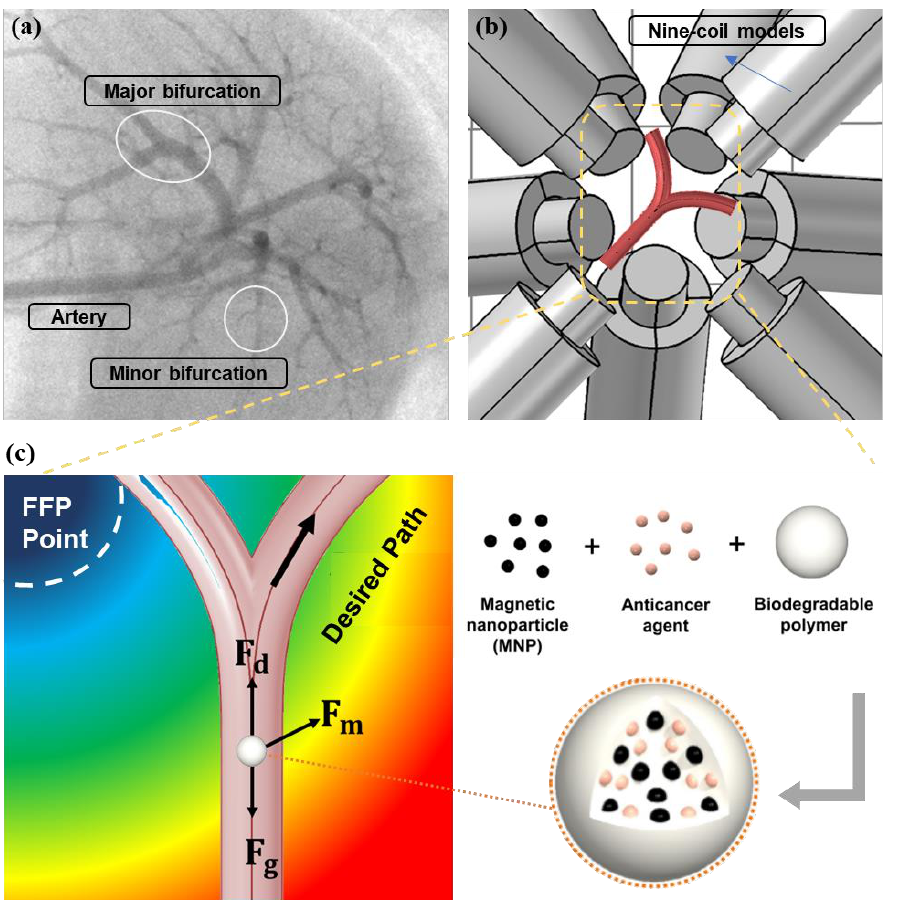
Figure 1. ( a ) Complexity of endovascular navigation in the portal vein of the rat. ( b ) Animated description of Y-shaped blood vessel bifurcation surrounded by a nine-coil electromagnetic actuators (EMA) system. ( c ) General concept of polymer-based microrobot with superparamagnetic nanoparticles (MNPs) along with free-body diagram of forces acting on microrobot steered by field-free point (FFP) position in blood vessel ; 𝐹 𝑑 ⃗⃗⃗⃗ ,𝐹 𝑚 ⃗⃗⃗⃗ , 𝑎𝑛𝑑 𝐹 𝑔 ⃗⃗⃗ are the hydrodynamic drag, magnetic, and gravitational forces, respectively.